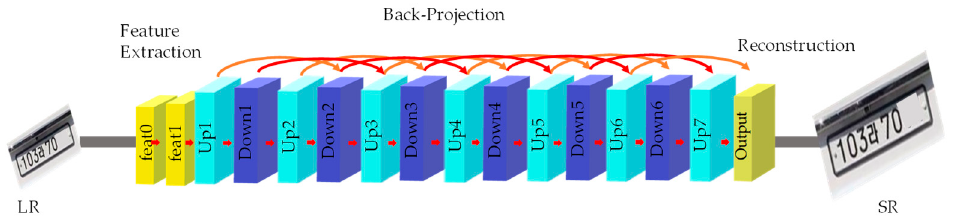
Figure 1. Iterative up and down blocks for SR framework. Two characters were masked due to privacy policies.